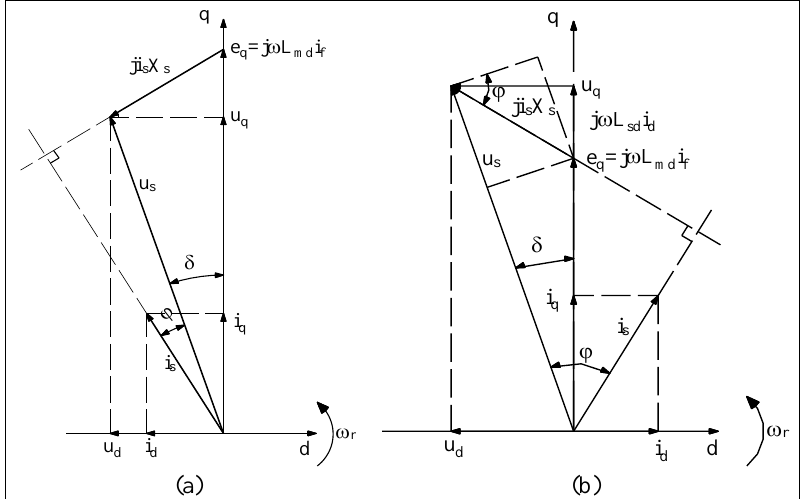
Figure 7. Vector diagram of a synchronous motor in steady-state mode when stator winding resistance is ignored, with X s =  L s : (a) Current leads of voltage in phase, and (b) Current lags behind voltage in